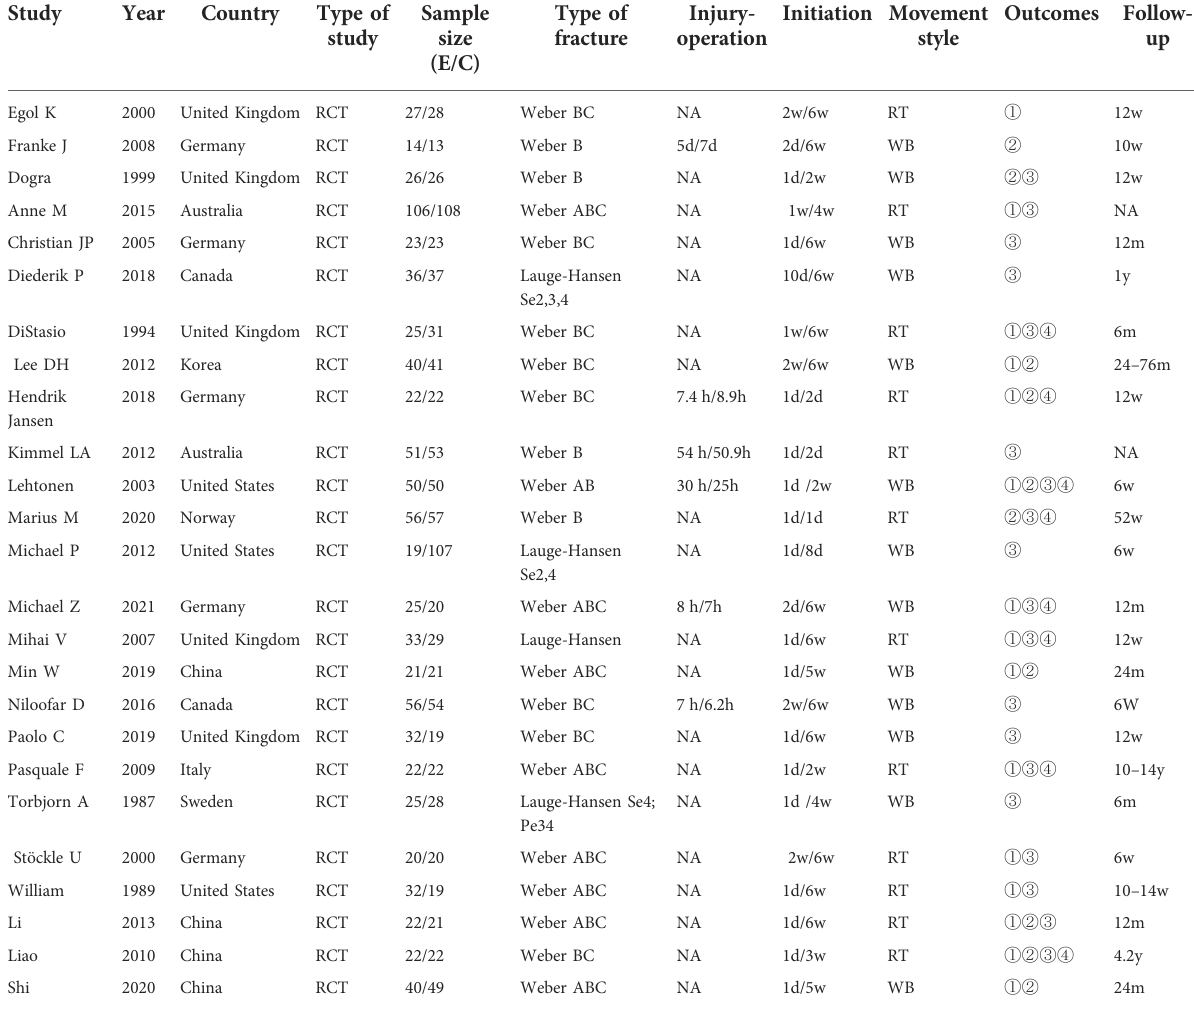
TABLE 1 Basic characteristics and quality evaluation of the included